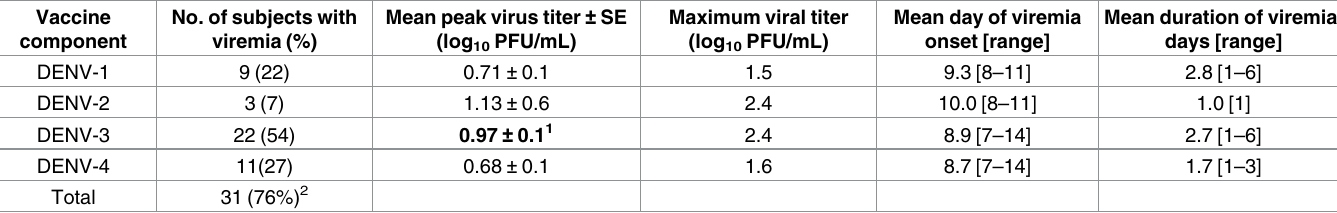
Table 2. Viremia following the first dose of TV003 in flavivirus-experienced subjects (n = 41) a . Vaccine No. of subjects with component viremia